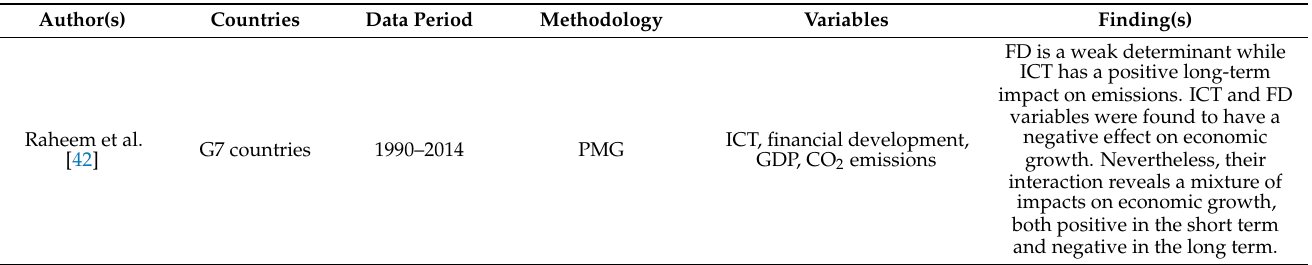
Table 1. The literatures between ICT, renewable energy, economic growth, CO 2 emissions, and energy